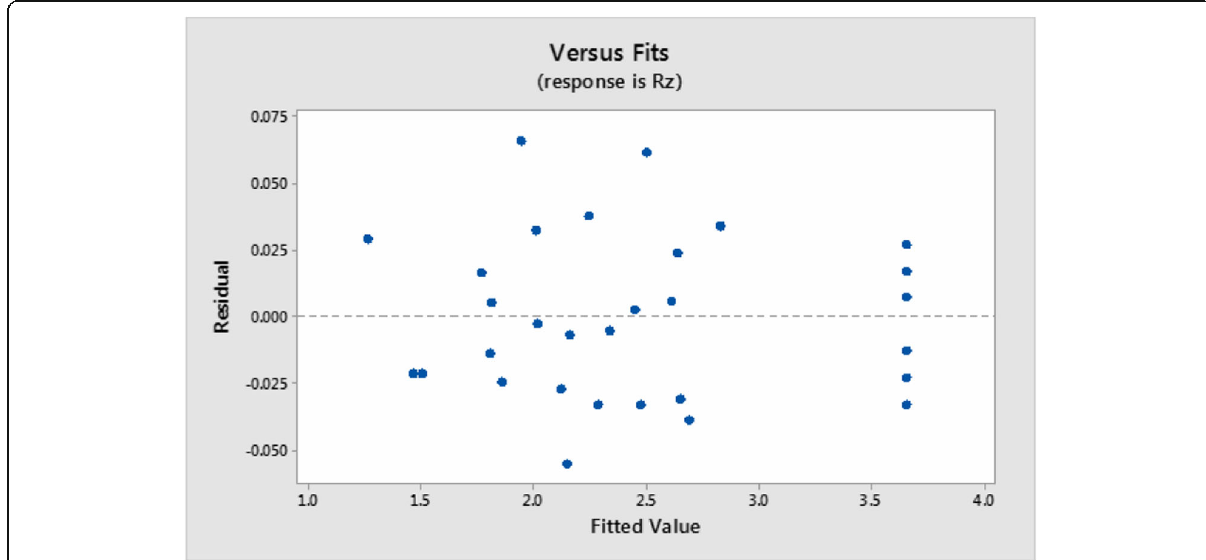
Fig. 5 Plot of residuals vs. predicted response for R